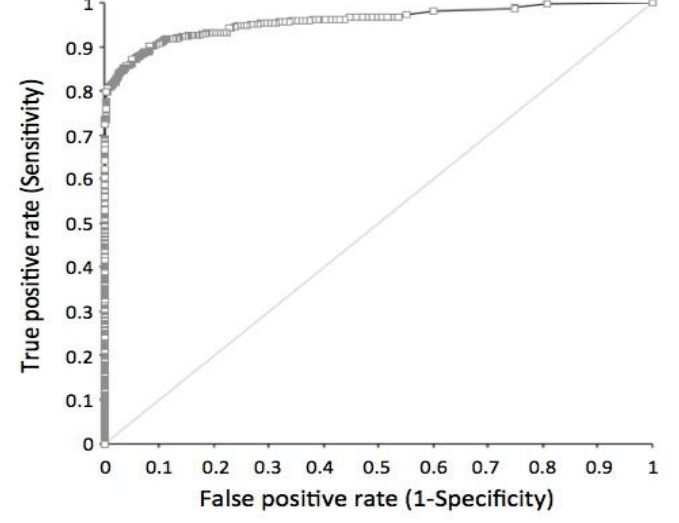
Figure 1. Receiver operation characteristic (ROC) analysis of the chemiluminescent dot blot assay of 720 cancer patients with 11 different types of tumours and of 4,103 healthy people and people with different types of illnesses, except for individuals with pre-malignant or malignant diseases. The ROC value is 0.96. See Table 2 for statistical